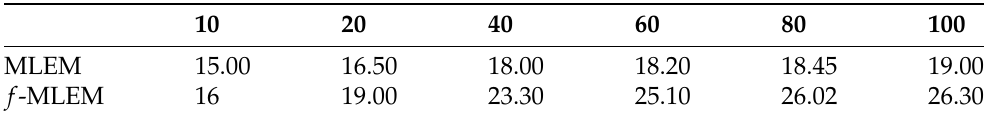
Table 1. Signal-to-noise ratio (SNR) by varying number of iterations for f -MLEM and MLEM algorithms. Test image: Huffman